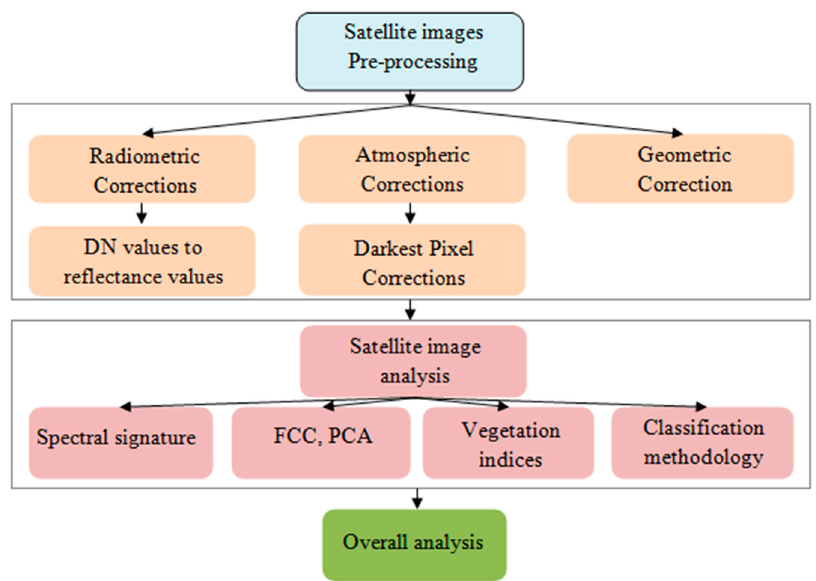
Figure 2. Hierarchical structure of methodology and satellite image data processing.